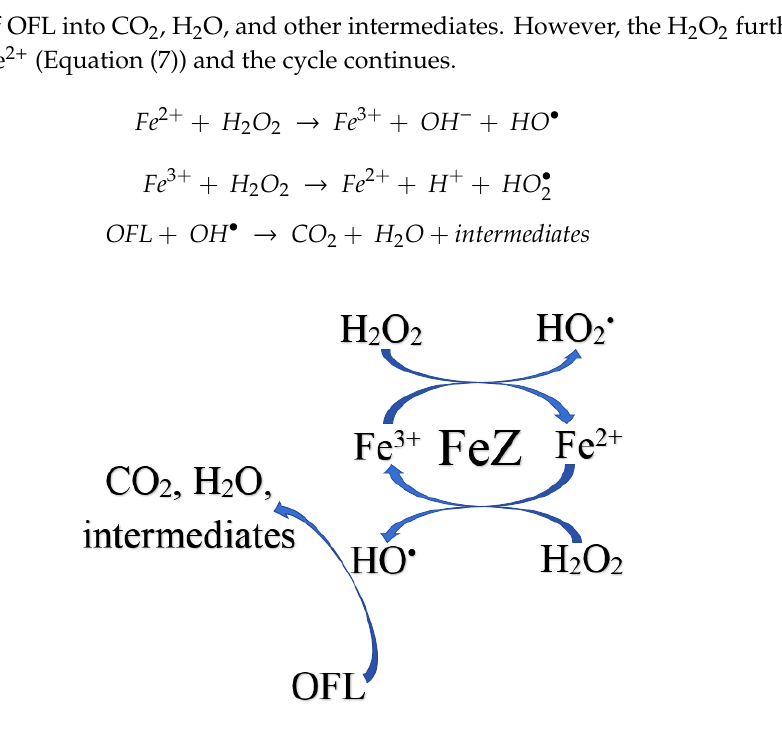
Figure 9. Proposed reaction pathway for OFL degradation using FeZ composite as hetero-Fenton catalyst.